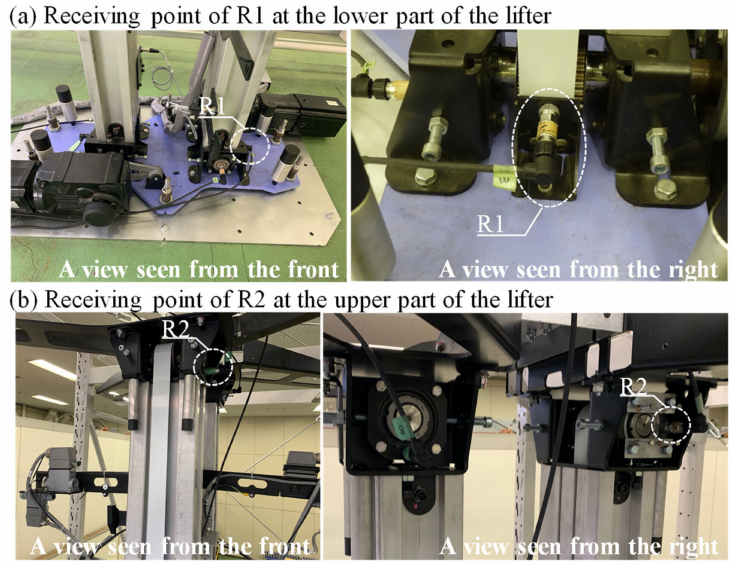
Figure 11. Details of the setting of the vibration receivers on the surface of the lifter. In these pictures, the upper one indicates ( a ) receiving point of R1, while the lower one indicates ( b ) that of